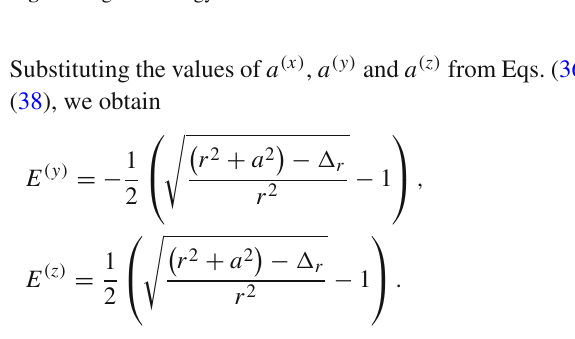
Fig. 7 Negative energy as a function of r